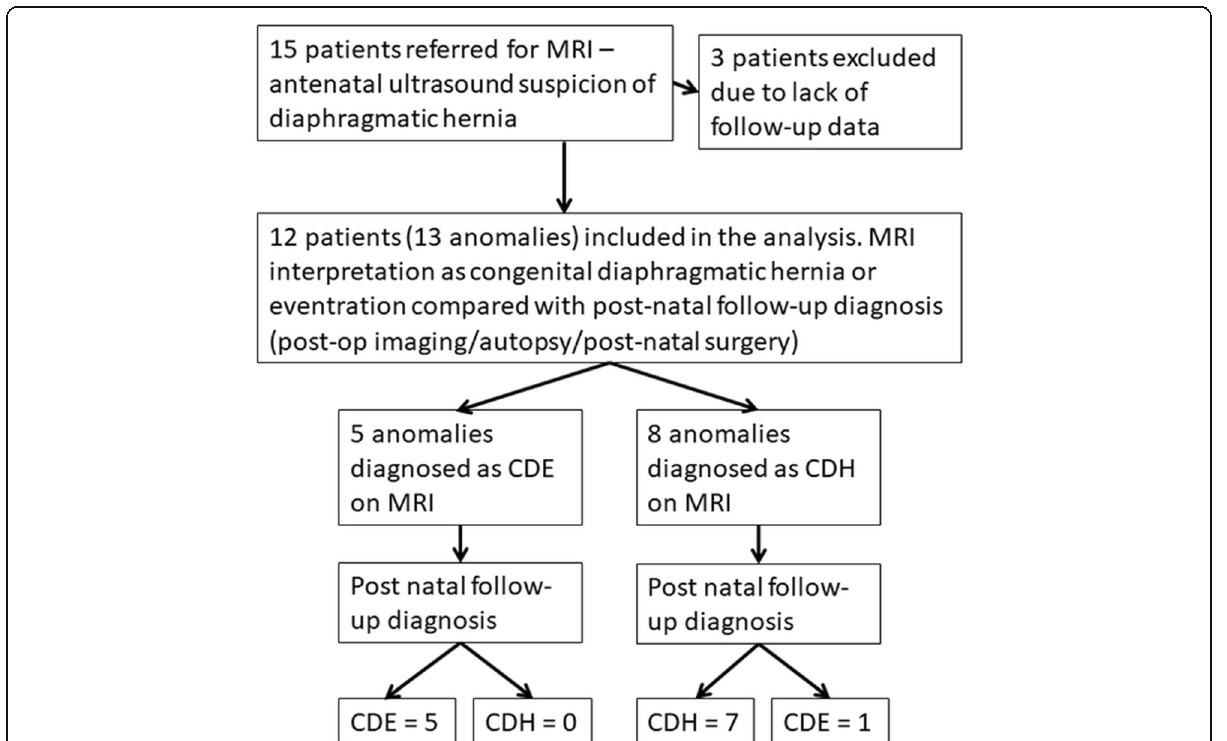
Fig. 1 Flow chart representing the study outline and results. CDE, congenital diaphragmatic eventration; CDH, congenital diaphragmatic hernia; MRI, magnetic resonance